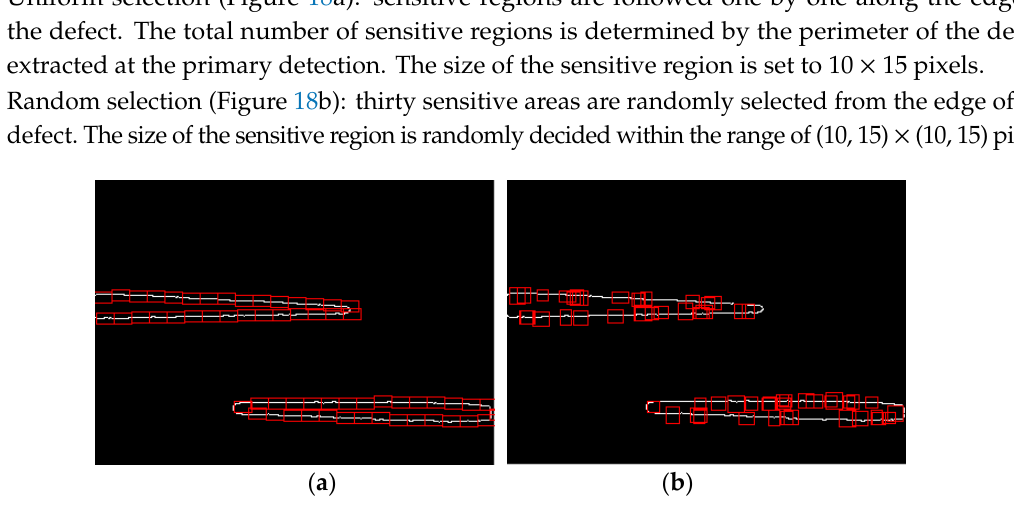
Figure 18. Two sensitive regions selection methods: ( a ) Multiple sensitive areas selected uniformly; ( b ) 50 multiple sensitive areas selected randomly.